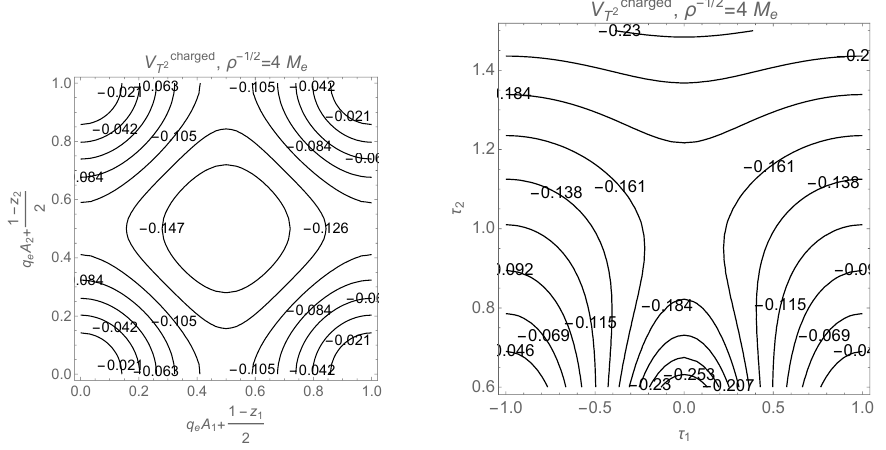
Figure 10 . U(1) gauge theory with charged matter. Left: the potential as a function of the Wilson line moduli. Right: the potential as a function of the (cid:28)